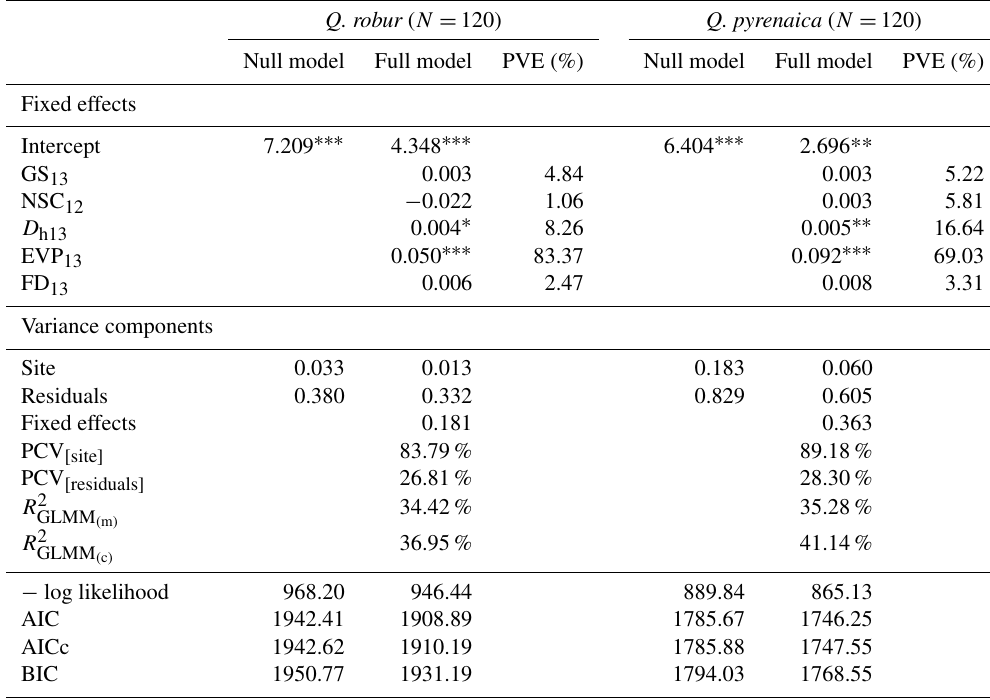
Table 2. Statistics of the null and full generalized linear models for Quercus robur (left) and Q.pyrenaica (right). Q. robur ( N =